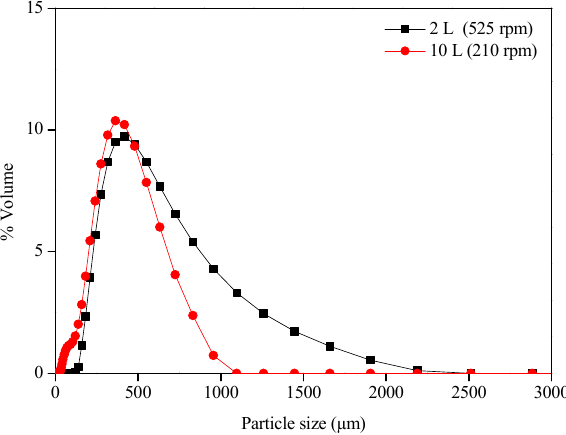
Figure 3. Particle size distribution for 2 L and 10 L reactions in volume median.